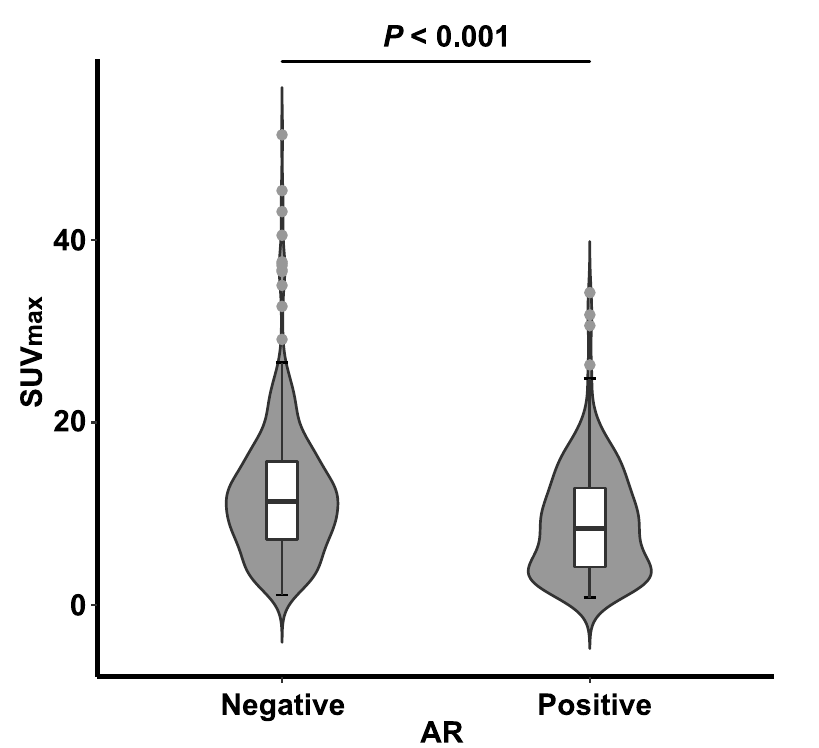
Fig 2. Difference of SUV max according to AR status in FDG PET analysis. SUV max is higher in AR-negative than in AR-positive TNBC. Violin plots indicate the distribution of SUV max according to the AR positivity. Box plot inside the violin plot denotes median value as a central line within a box, 25 percentile and 75 percentile value as an outline of a box and minimum and maximal number are marked as error bar with outliers marked separately. AR, androgen receptor expression on immunohistochemistry.